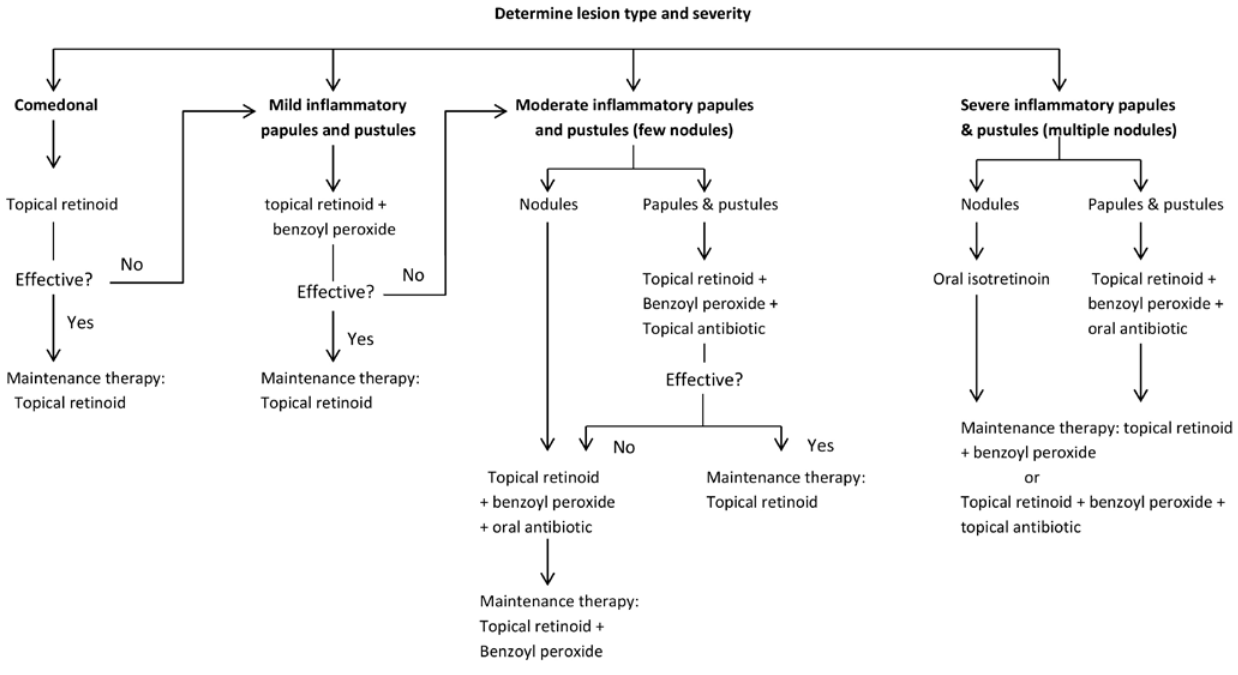
Figure 1: A treatment algorithm for the management of acne